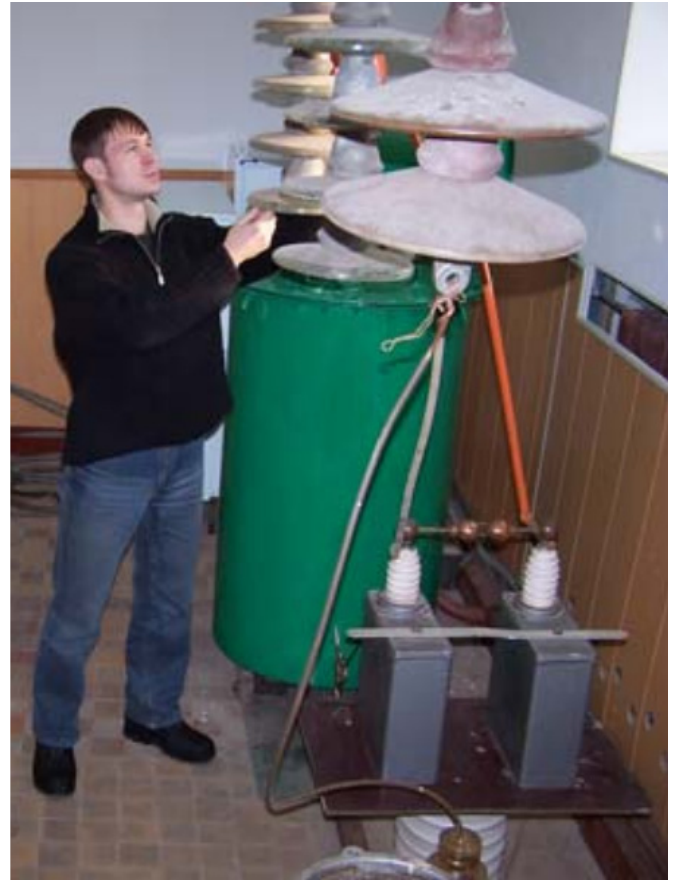
Fig. 1. Insulator testing